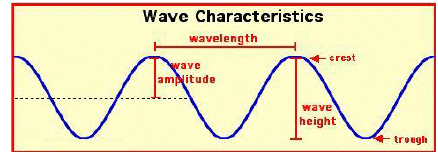
Figure 3 The picture showing the intensity of tsunami waves compared to wind generated waves Tsunamis have a small amplitude offshore and a very long wavelength which is why they generally pass unnoticed at sea, forming only a slight swell above the normal sea surface. They grow in height when they reach shallower